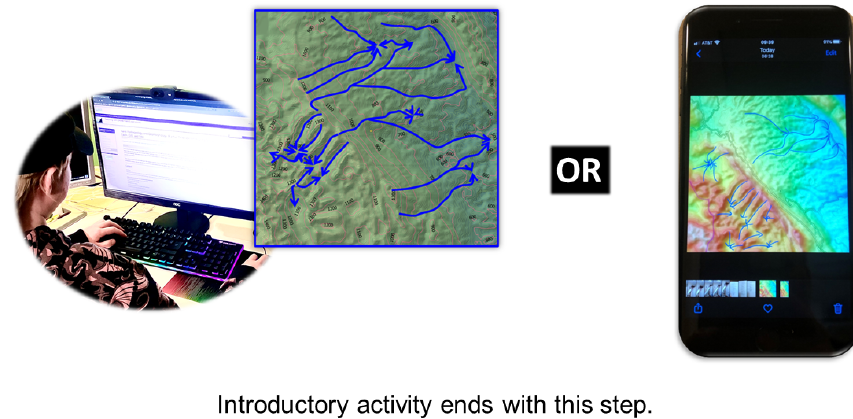
Figure 5. Manually drawn water flow paths created in © Google Slides (left) and an iPhone photo markup (right). Photo by the